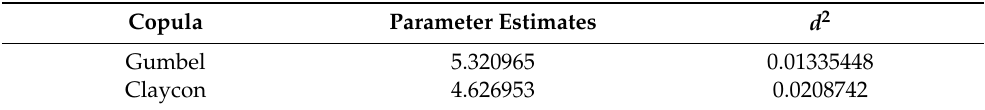
Table 5. Dependency parameter and Euclidean distance d 2 between the copula function and the empirical copula based on